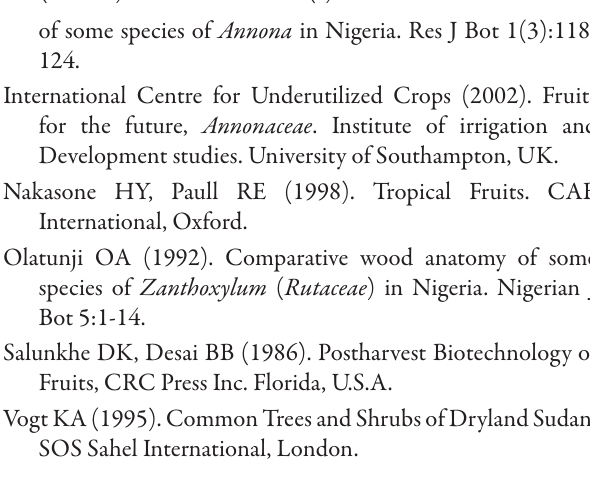
Fig. 11. Annona squamosa ; Fibre tracheids (a and b) and libriform fibre